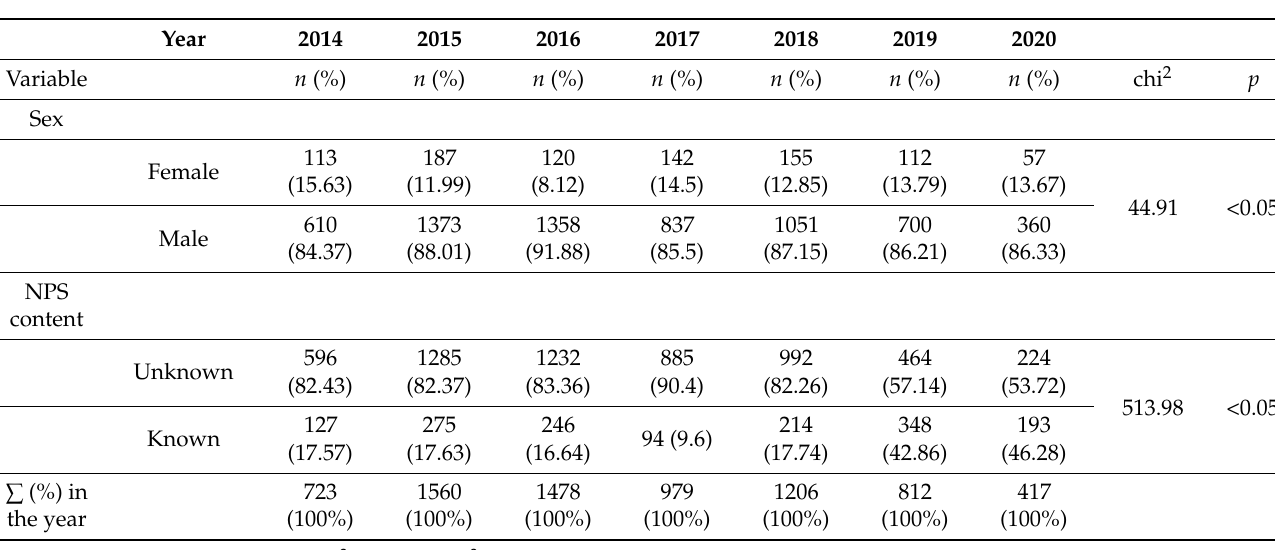
Table 3. The characteristics of intoxications with regard to a patient’s gender and NPS content in particular years.